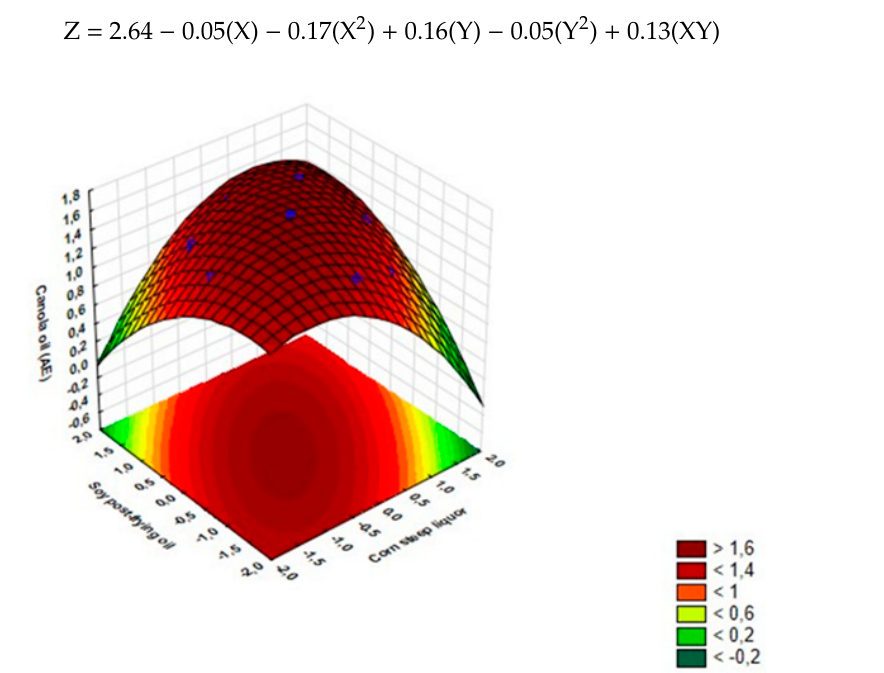
Figure 2. Response surface graphic for interactive effect between concentrations of corn steep liquor (%) and waste cooking oil (%) on emulsification activities (EA) in canola oil.